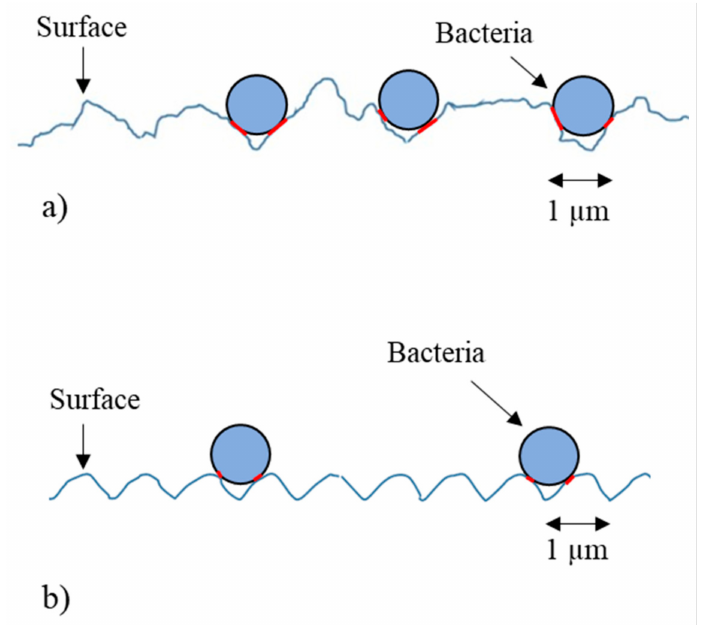
Figure 6. The bacteria retained on the surfaces were bound in the highest amounts on the surfaces with ( a ) irregular topographies rather than on ( b ) topographically regular